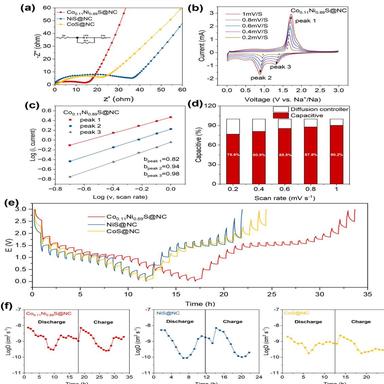
(a) EIS spectra of Co0.11Ni0.89S@NC, NiS@NC, and CoS@NC; (b) CV curves of Co0.11Ni0.89S@NC at different scan rates range from 0.2 to 1 mV s −1; (c) Log i vs. Log v plots of Co0.11Ni0.89S@NC; (d) Capacitive contribution at distinct scan rates; (e) Charge-discharge GITT curves at 200 mA g−1 of Co0.11Ni0.89S@NC, NiS@NC, and CoS@NC; (f) Log of the Na+ diffusion coefficient in Co0.11Ni0.89S@NC, NiS@NC, and CoS@NC during the discharge and charge.